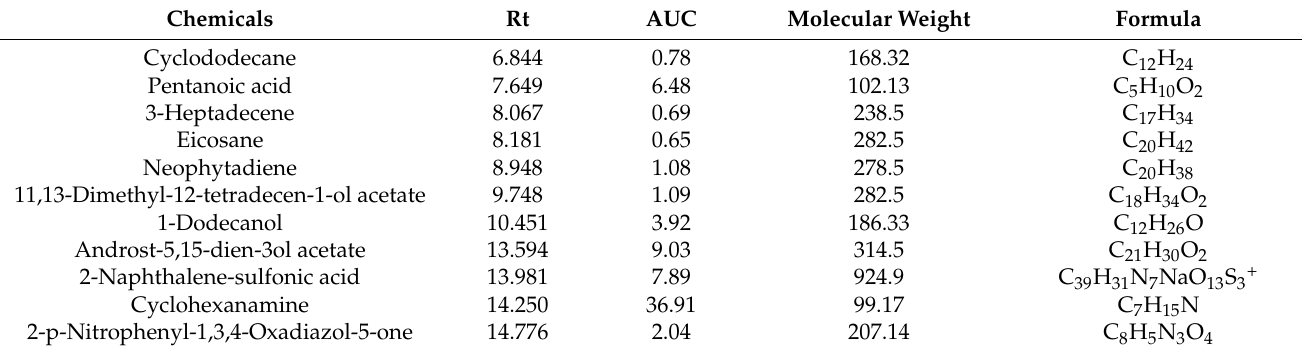
Table 1. Identified chemicals in Bulung Boni chromatogram.